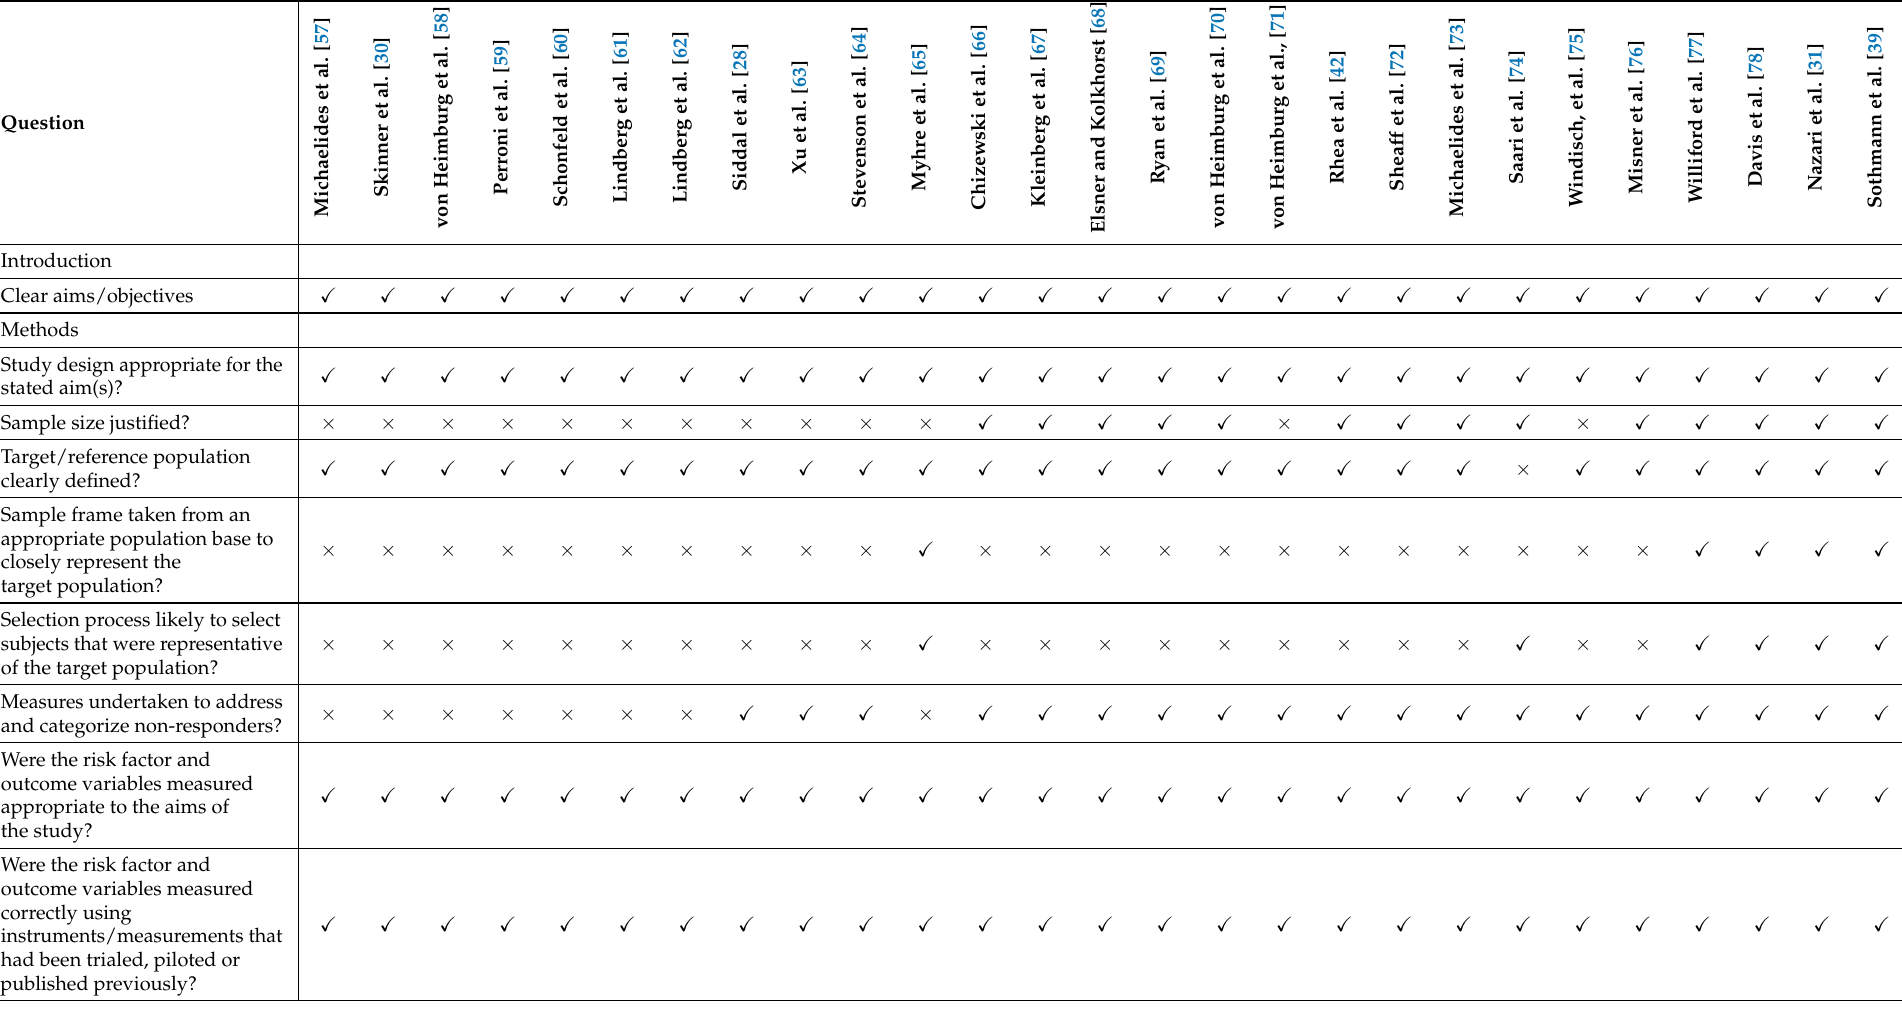
Table 1. Critical appraisal of cross-sectional studies using AXIS